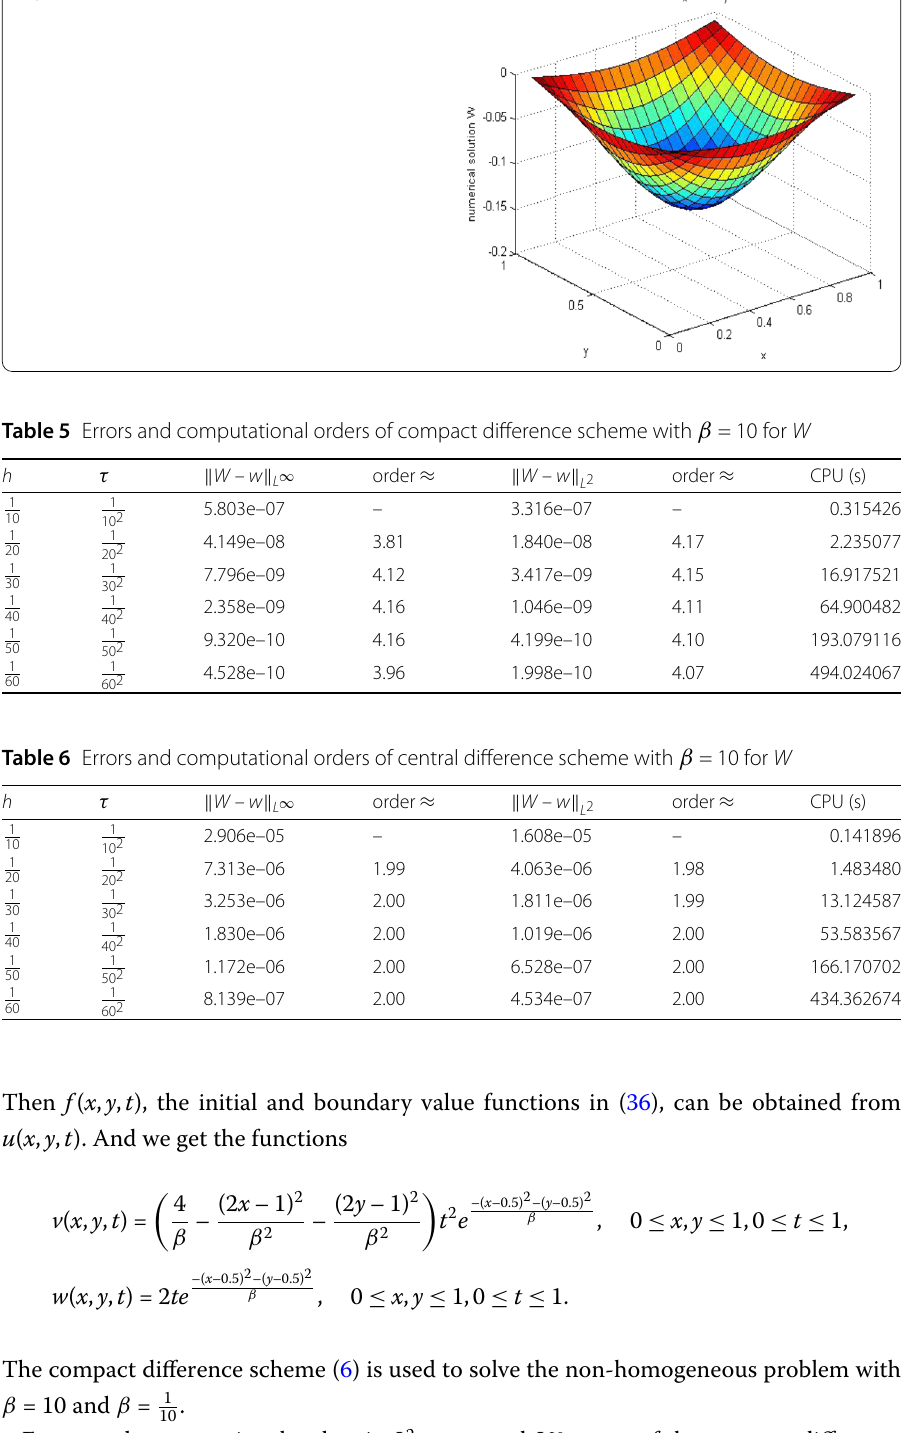
Figure 4 Numerical solution W